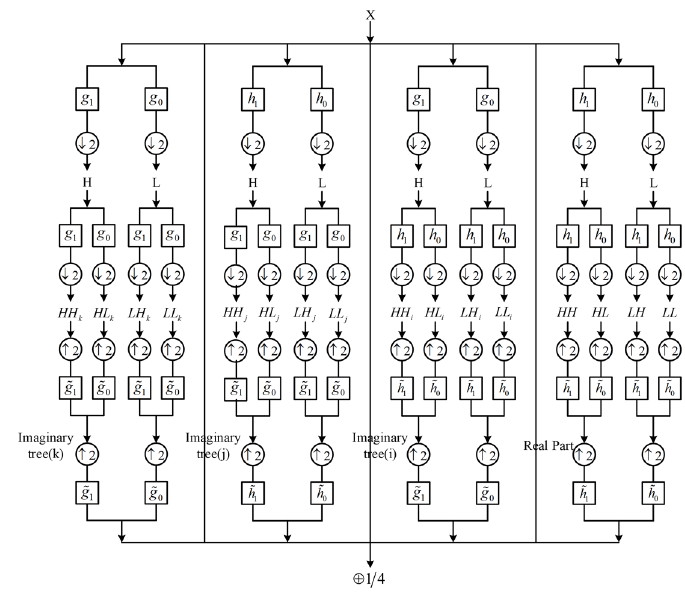
Figure 2. Flow chart of QWT algorithm.